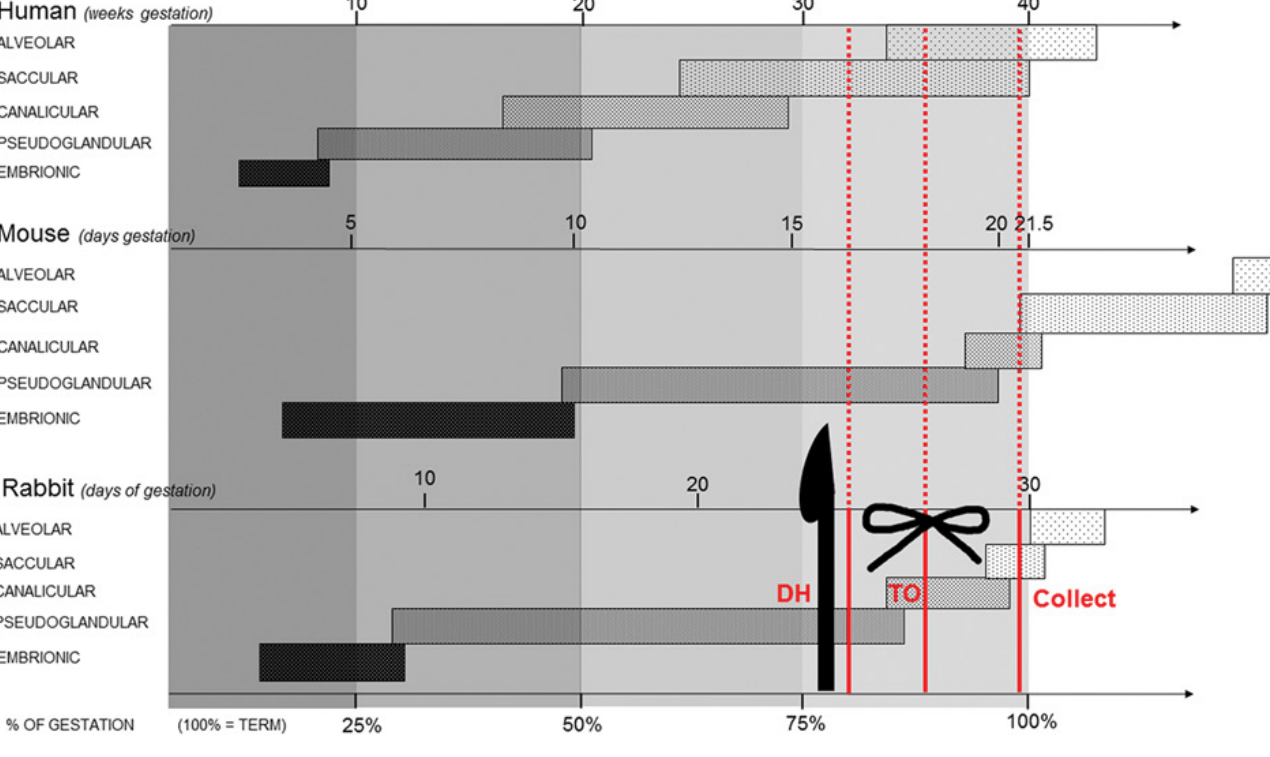
Figure 1. CDH and CDH/TO Model Overview. Comparison of human, rabbit and mouse lung development and with time points of each intervention in the fetal rabbit model